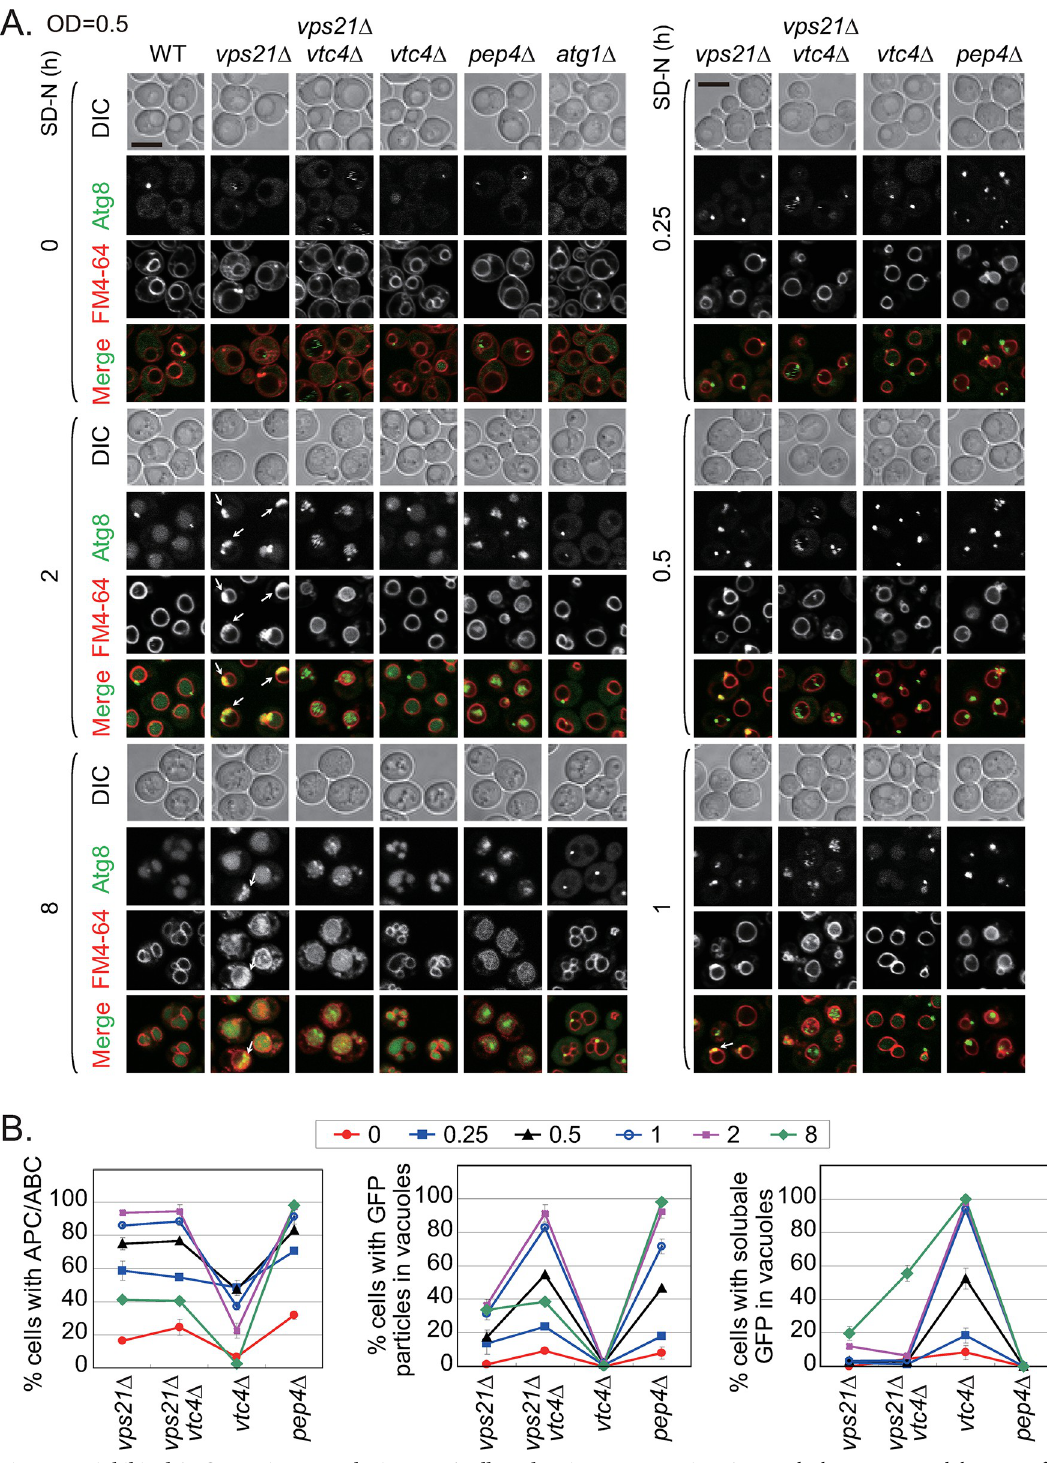
Fig 8. Vtc4 inhibited APC entry into vacuoles in vps21 Δ cells under nitrogen starvation. A. Vtc4 depletion promoted the entry of accumulated APCs into vacuoles in vps21 Δ cells under nitrogen starvation. The indicated GFP-Atg8-labeled cells were grown and examined as described in Fig 2. The four core strains incubated in SD-N medium between 0–2 h are presented on the right side. Scales bars, 5 μ m; arrows, APCs. B. Quantification of the location and format of GFP signals in the four core strains represented in panel A. The percentages of cells in panel A with APCs/ABCs (left), GFP particles in vacuoles (middle), and soluble GFP in